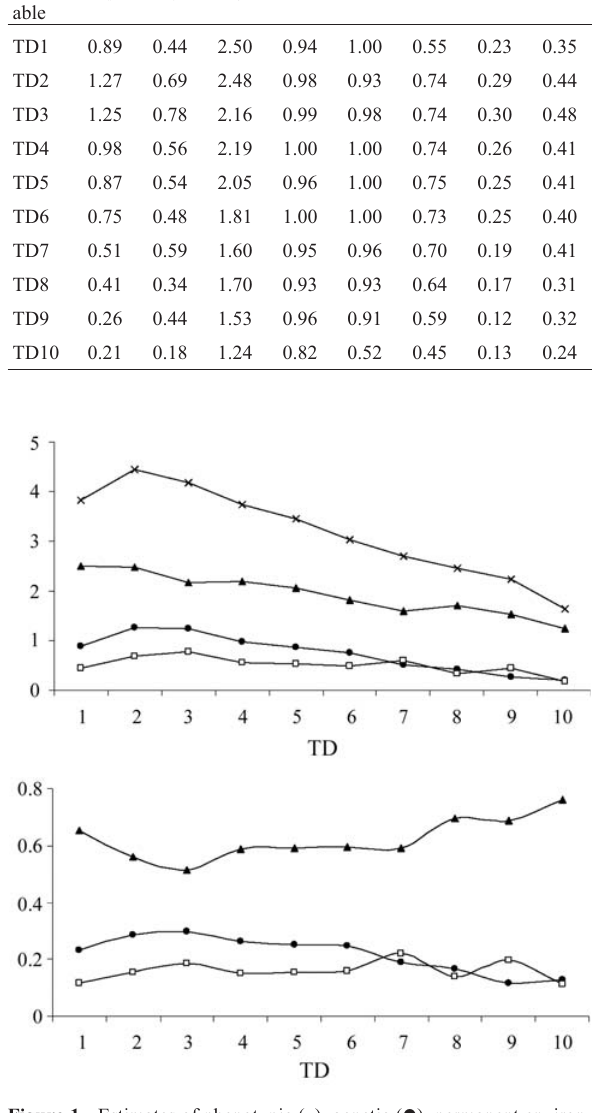
Figure 1 - Estimates of phenotypic (x), genetic ( (cid:2) ), permanent environ- mental ( (cid:3) ) and residual ( (cid:2) ) variances (top) and estimates of heritability ( (cid:2) ) and permanent environmental ( (cid:3) ) and residual ( (cid:2) ) variances as pro- portions of phenotypic variance (bottom) for test-day milk yield